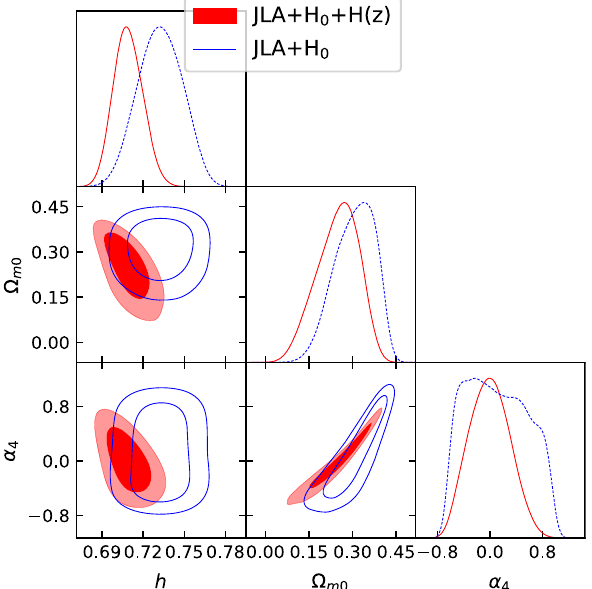
Fig. 4 The contour plot for interaction Q 4 with the 1 σ and 2 σ regions.